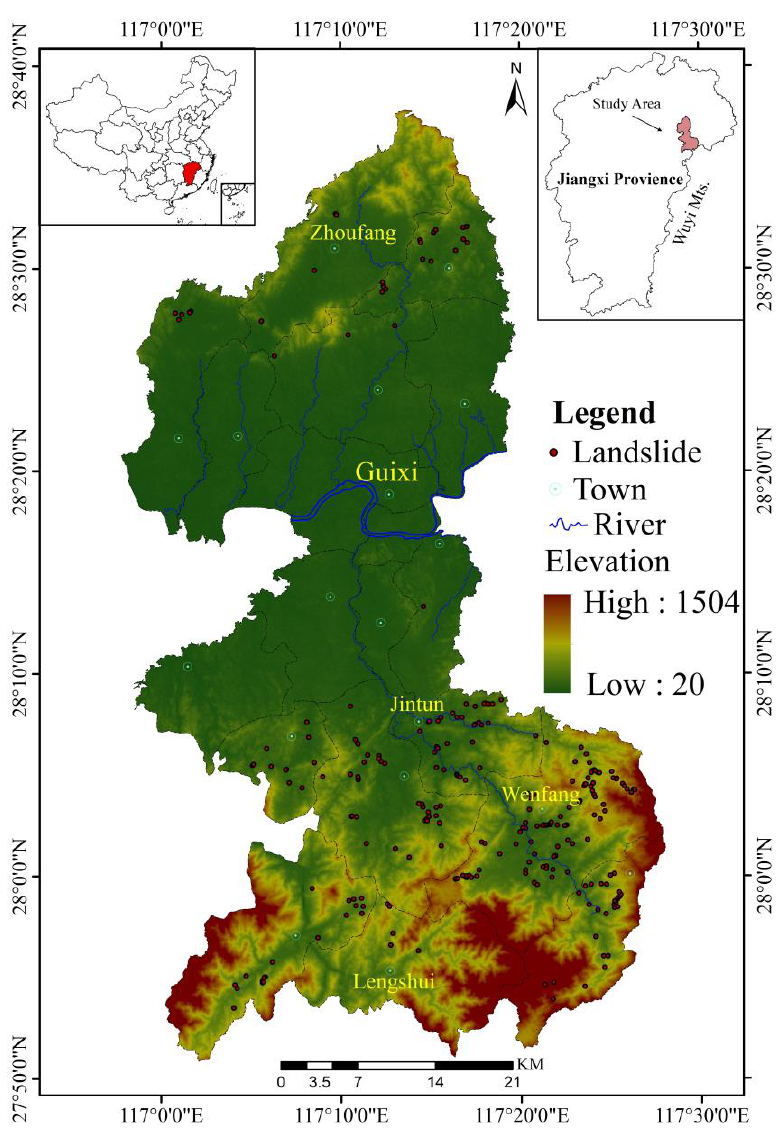
Figure 1. Location of the study area and distribution of the